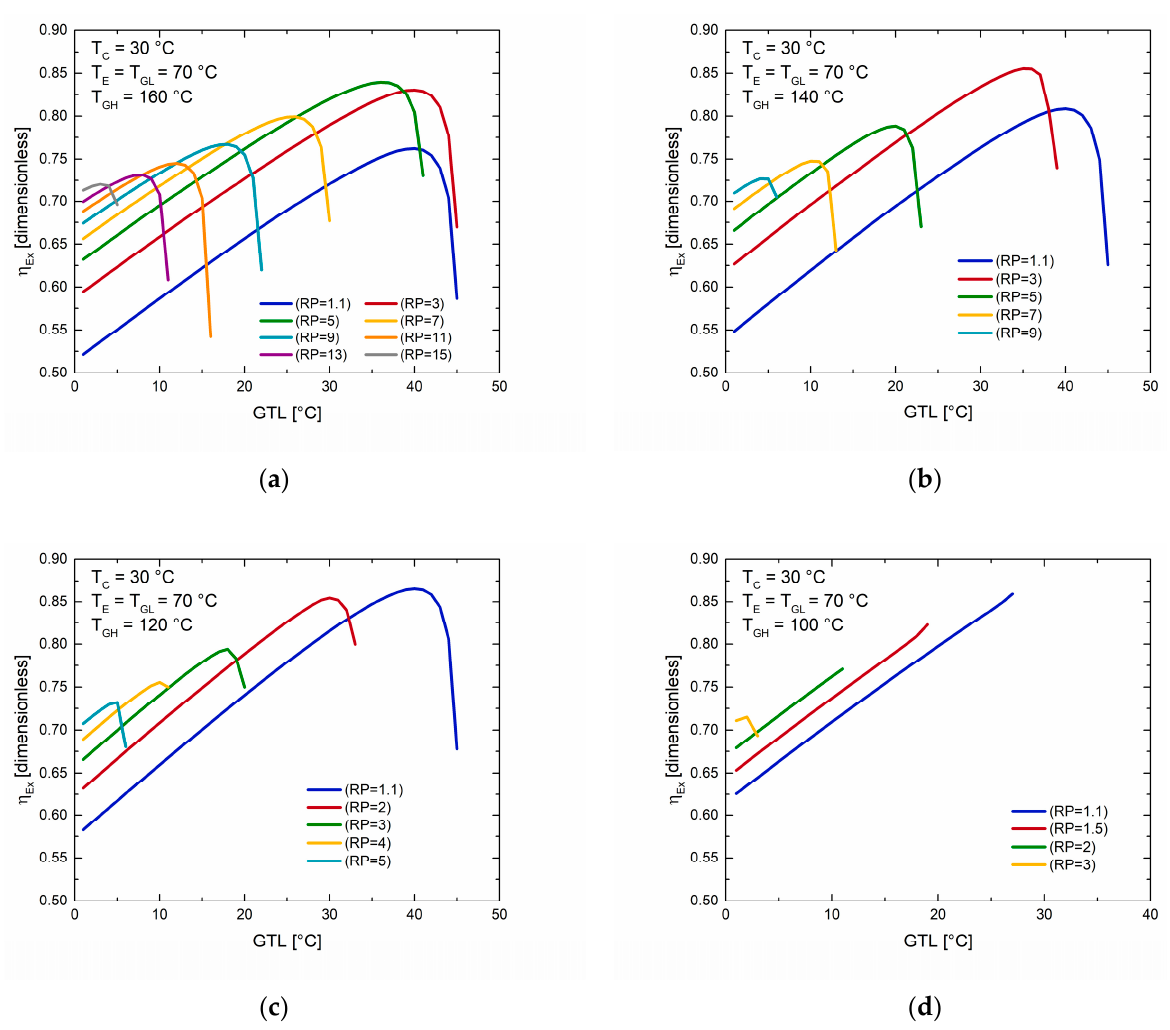
Figure 6. Exergetic efficiency ( η Ex ) as a function of GTL at different pressure ratios (RP). ( a ) T GH = 160 ◦ C; ( b ) T GH = 140 ◦ C; ( c ) T GH = 120 ◦ C; ( d ) T GH = 100 ◦